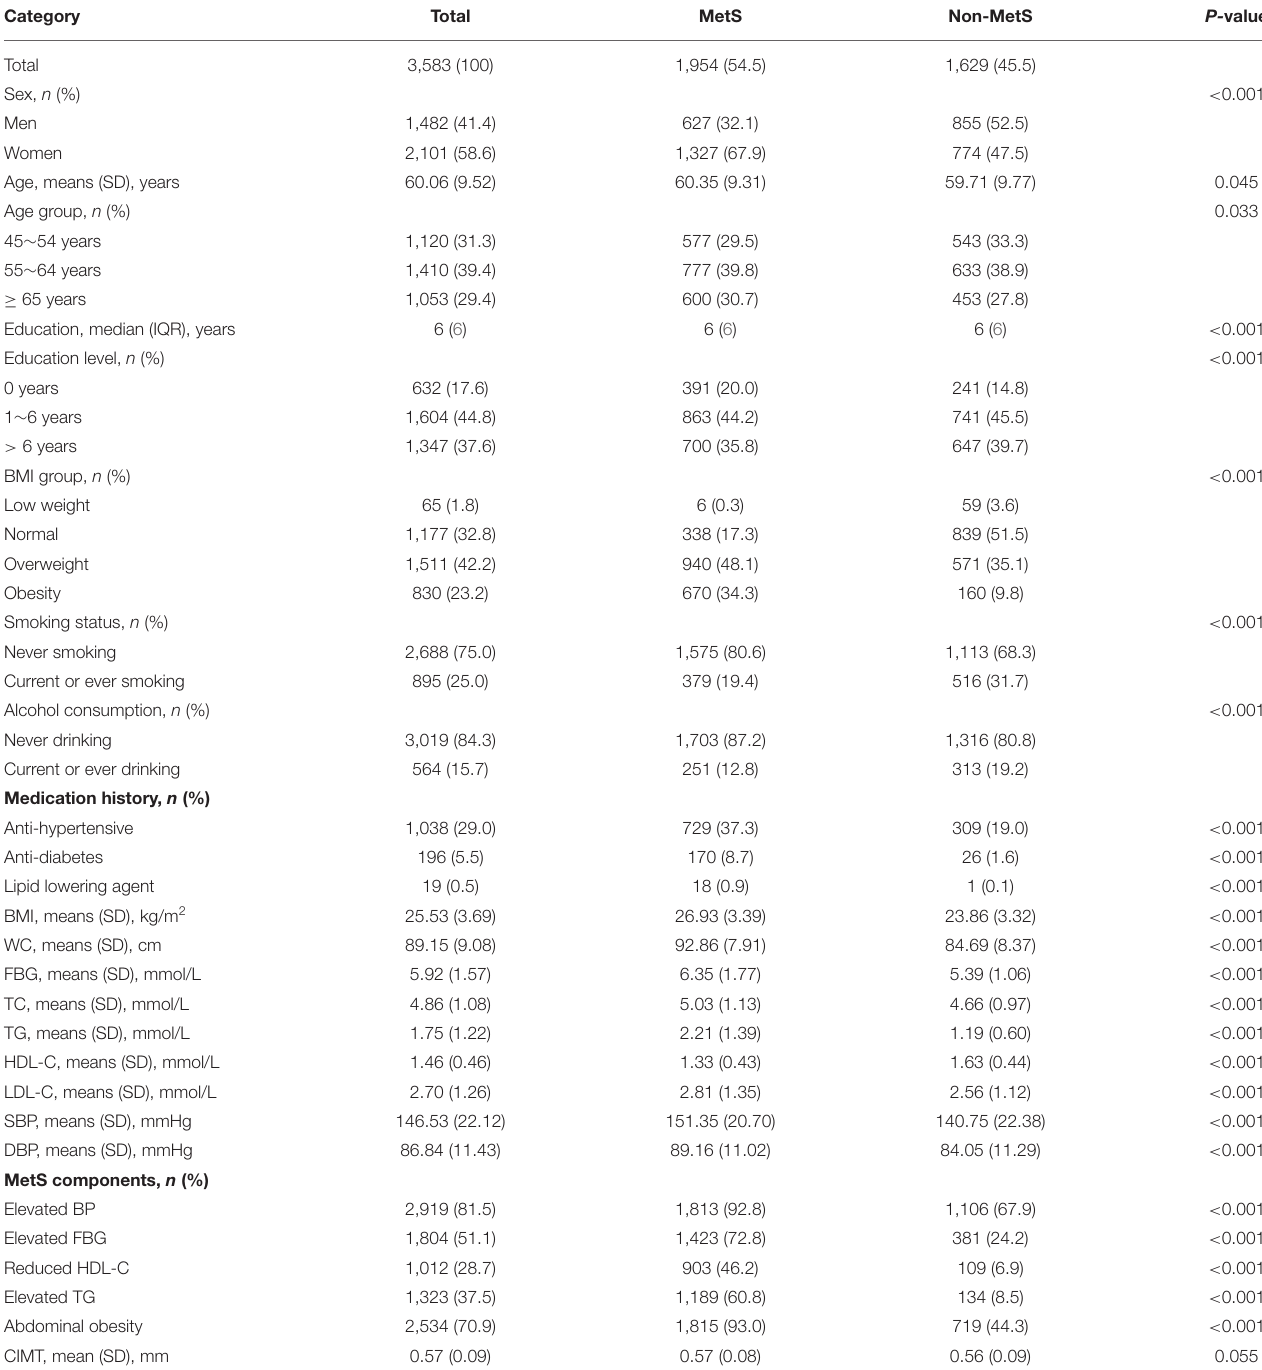
TABLE 1 | Characteristics of study